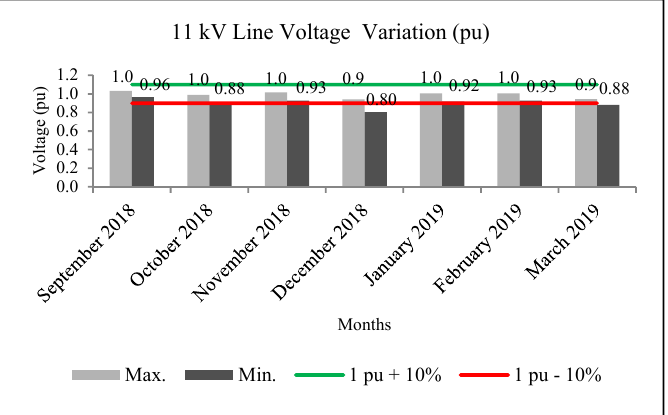
Figure 5. 11 kV Line voltage variation (pu) for different months at Manjarda.